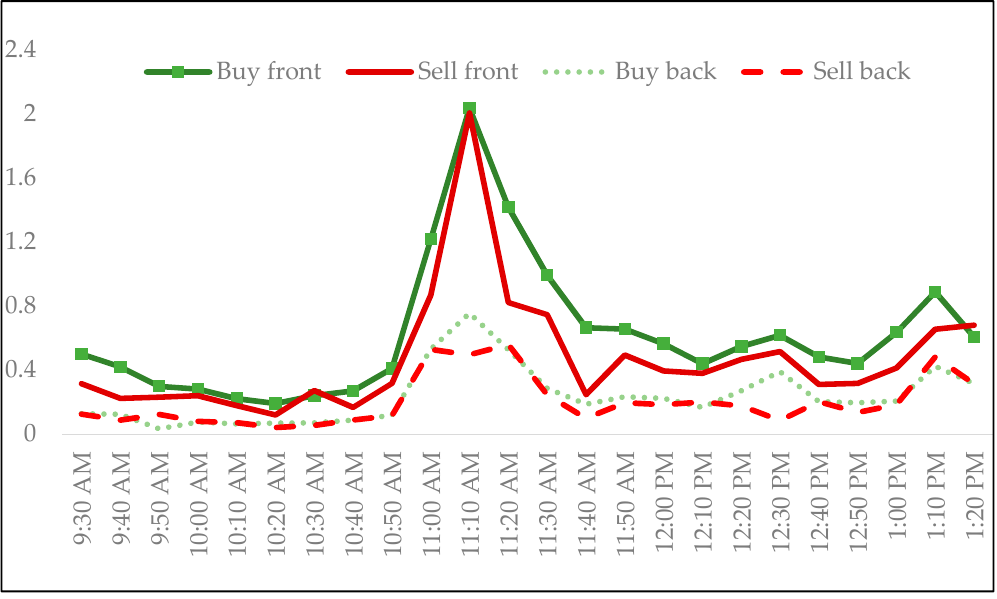
Figure 3. Evolution of the baseline intensity ( y -axis) for corn on March 31, 2016.